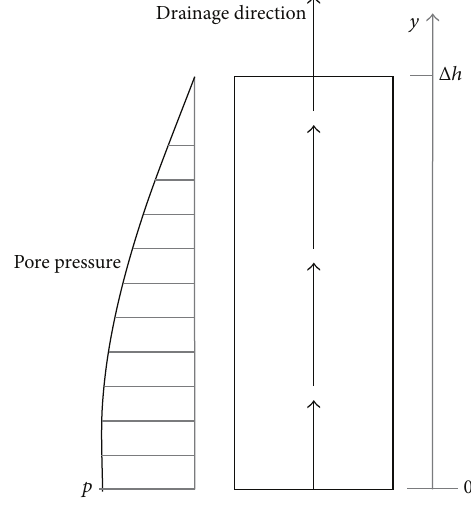
Figure 4: Schematic diagram of drainage in a